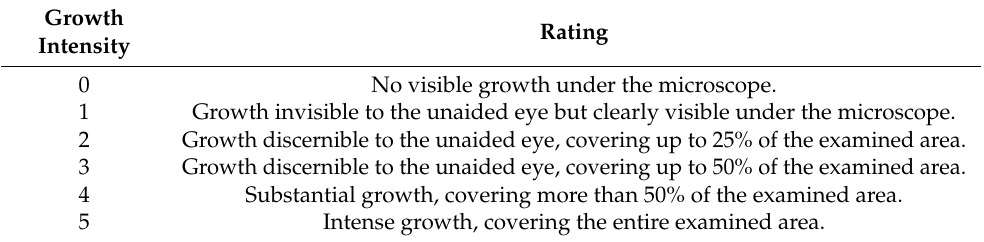
Table 2. Evaluation of microbial growth according to EN ISO 846